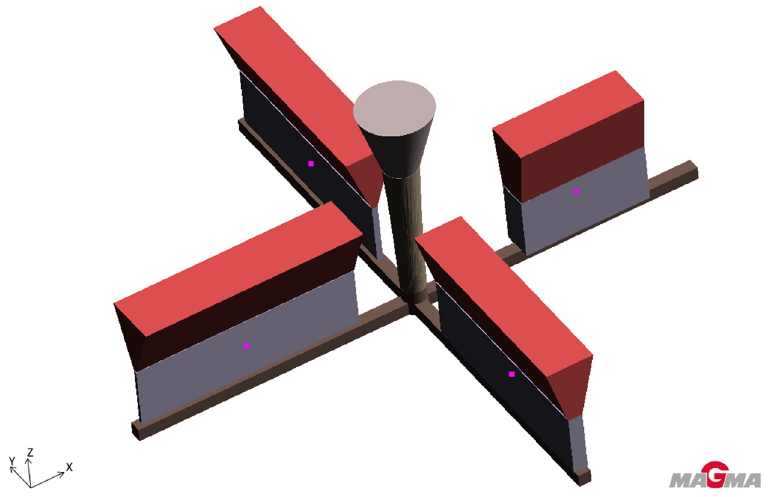
Figure 1. Outline of test block castings with different wall thicknesses (g = 3, 5, 13, and 25 mm).